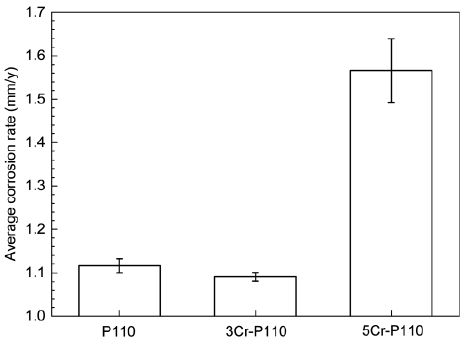
Figure 1. Average corrosion rates of P110, 3Cr-P110 and 5Cr-P110 tube steels in 3.5 wt % NaCl solution with CO 2 and H 2 S ( P CO2 = 5 MPa, P H2S = 0.2 MPa, 90 °C, 1 m/s, 360 h). The error bar of average corrosion rate was calculated from the three parallel specimens for each test.